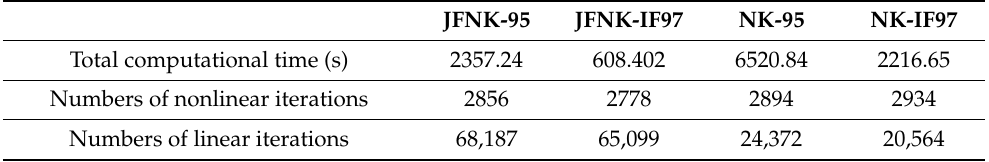
Table 11. Simulation time between different methods of step increase in inlet water